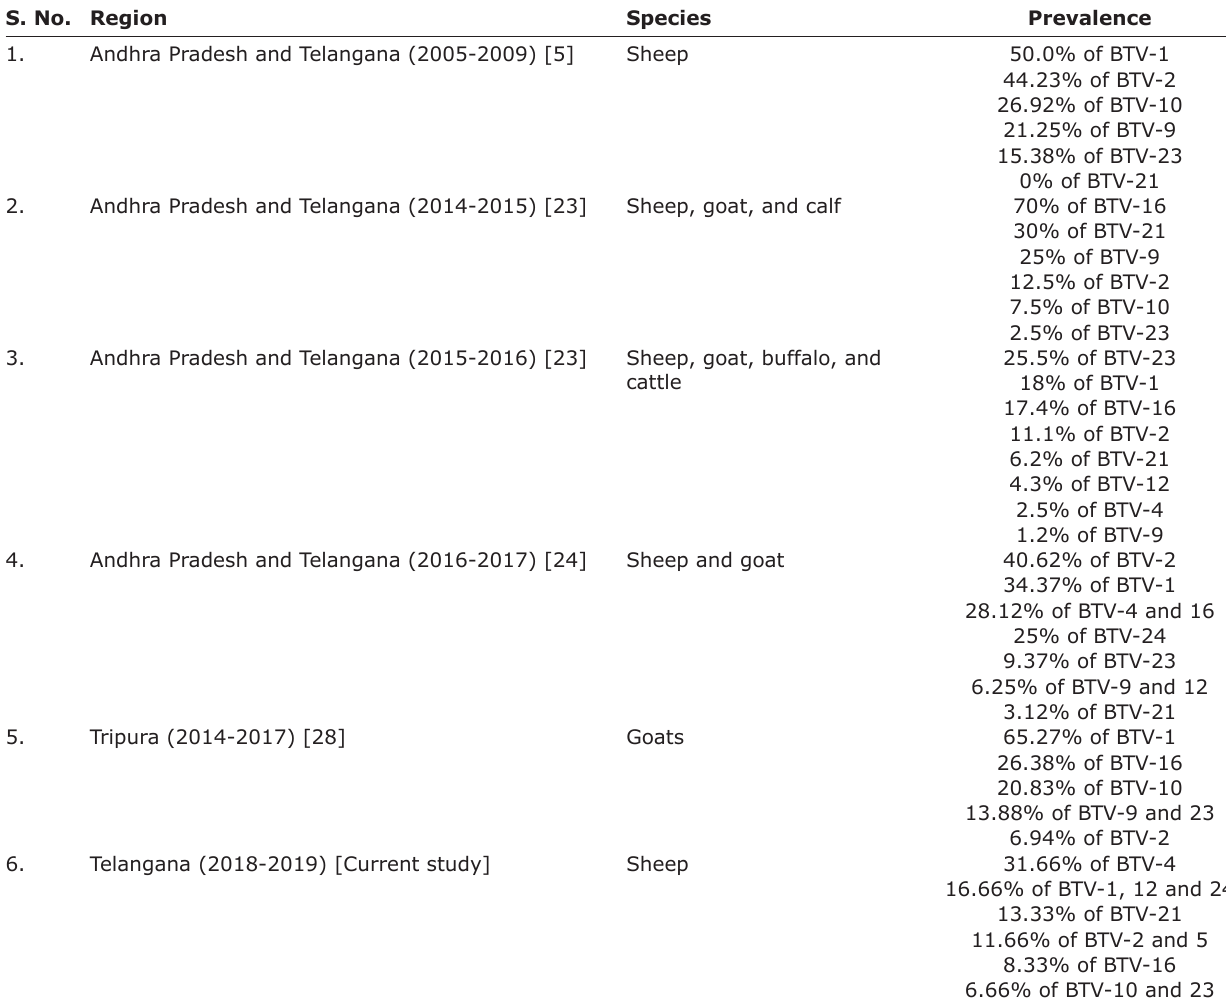
Table-3: Type-specific seroprevalence of BTV in various regions during different periods in India. S. No.